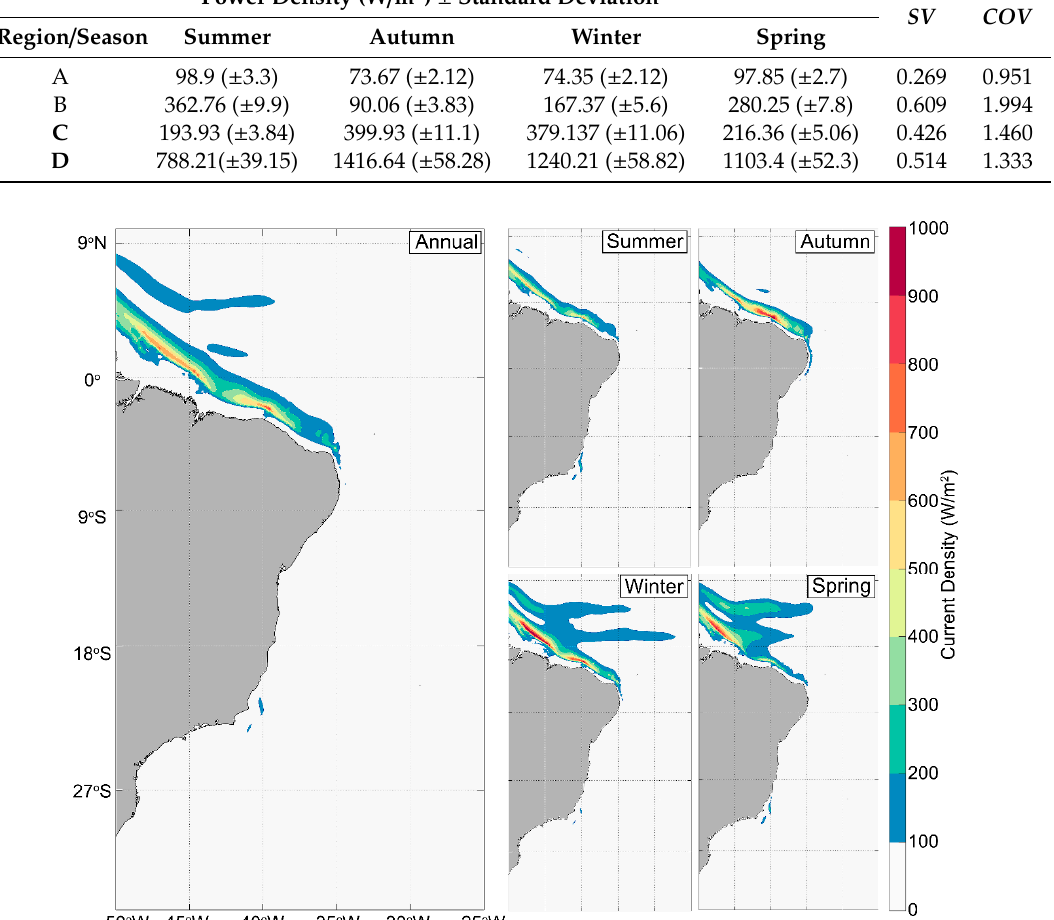
Figure 14. Annual and seasonal (summer, autumn, winter, and spring) mean power density (W/m 2 ) at the Brazilian coastline between January 1, 2007 and December 31, 2017. Table 3. Average values of the ocean current power density (W/m 2 ), standard deviation (±), seasonal variability (SV), and coefficient of variation (COV) for each coastline region—A, B, C and D—for each season (summer, autumn, winter, and spring) between January 1, 2007 and December 31, 2017.